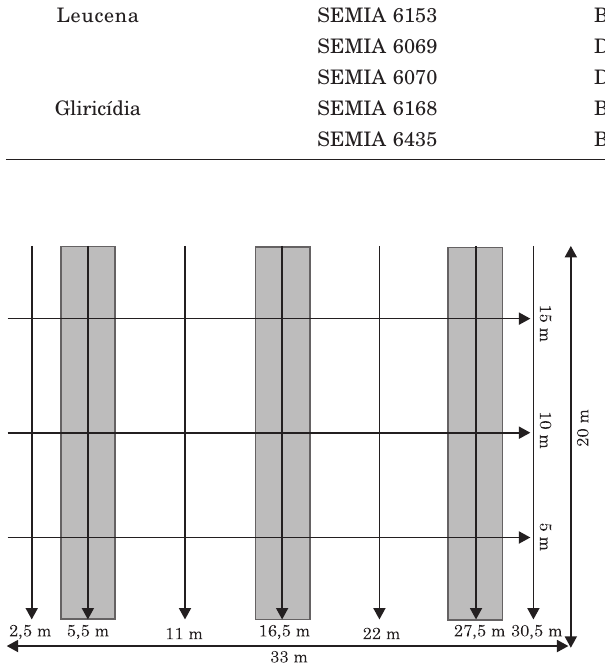
Figura 2. Distribuição dos pontos coletados no experimento em campo. As faixas cinzas indicam as linhas de plantio da leguminosa, enquanto as setas horizontais indicam os três transectos e, as verticais, os pontos de